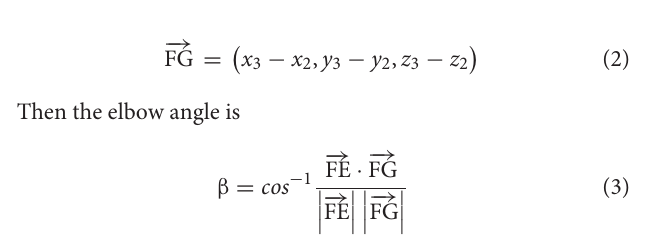
FIGURE 4 | Marker points in the motion capture system and the definition of the shoulder, elbow, and wrist angles.